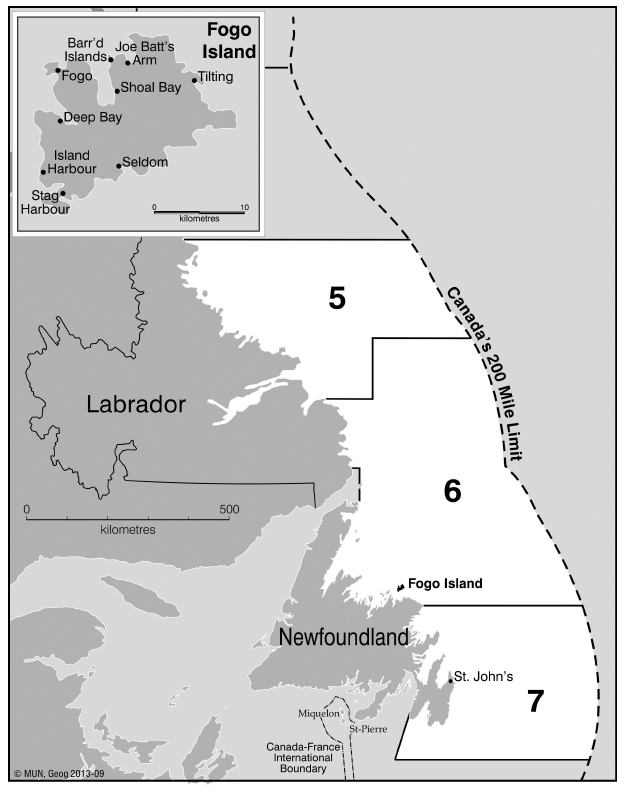
Fig. 2 . Fogo Island and Department of Fisheries and Oceans (DFO) Shrimp Fishing Areas